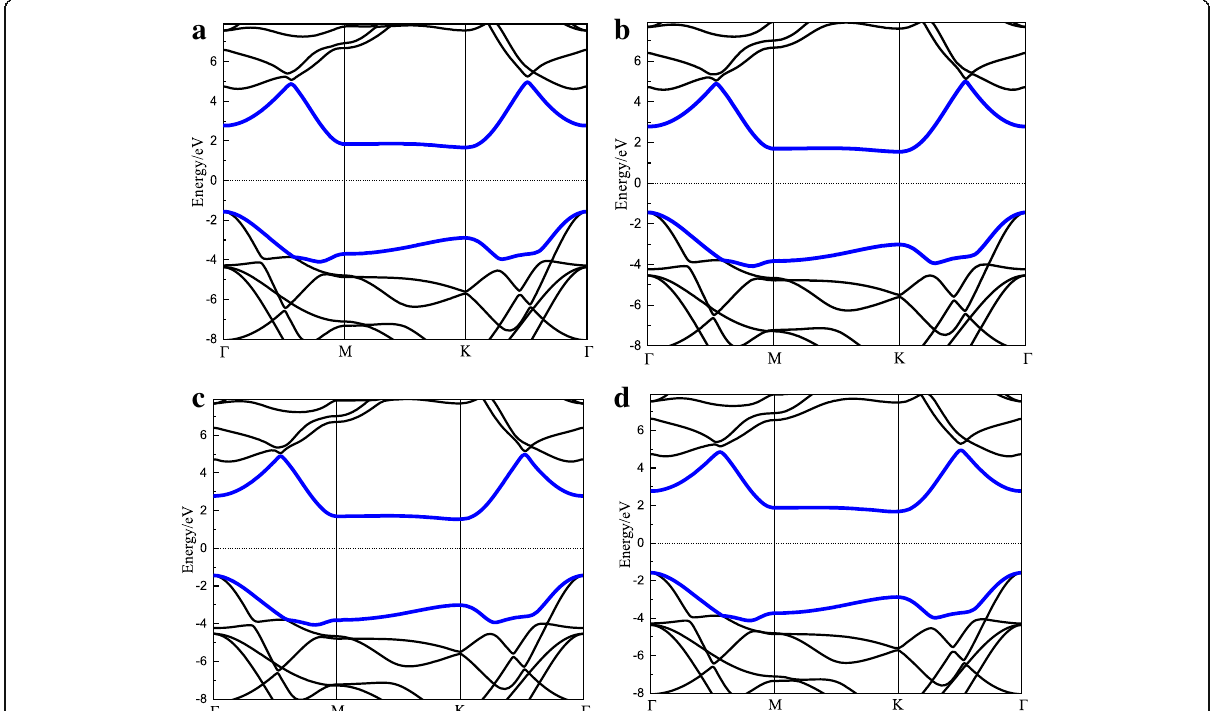
Fig. 2 a – d The band structures of 100%-HG/h-BN heterobilayer stacking patterns I – IV